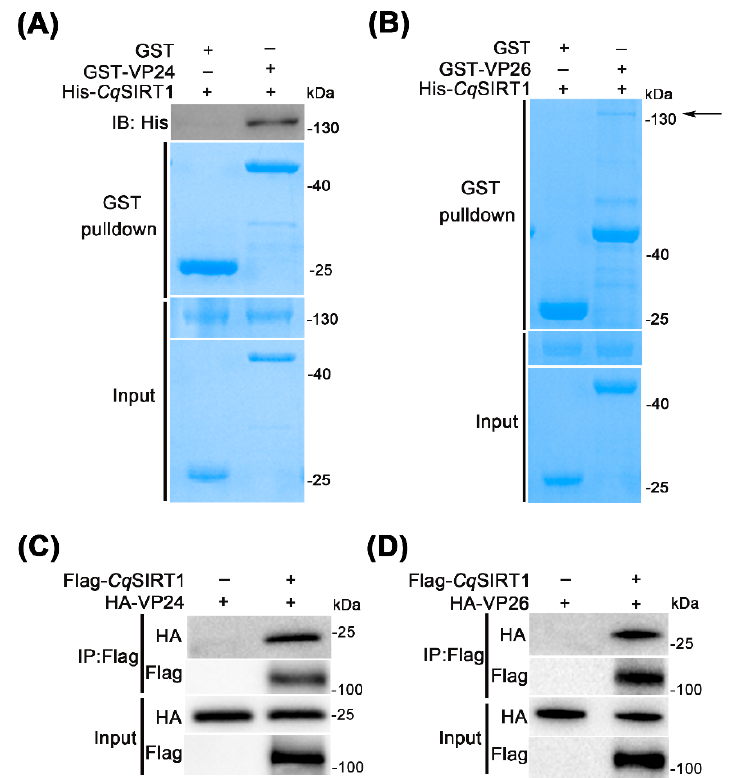
Figure 6. Cq SIRT1 bound to viral envelope proteins VP24 and VP26. ( A , B ) GST pulldown assay between recombinant protein Cq SIRT1 and VP24 or VP26. The GST pulldown assay was performed and followed by Coomassie brilliant blue staining and Western blot analysis with anti-His monoclonal antibody. GST recombinant protein served as negative control. ( C , D ) Flag- Cq SIRT1 was found to bind to HA-VP24 or HA-VP26 in the co-immunoprecipitation assay. Flag- Cq SIRT1 and HA-VP24 or HA-VP26 plasmids were co-transfected into HEK293T cell lines, then subjected to co-immunoprecipitation and Western blot analysis with the indicated specific antibody. These experiments were performed in biological triplicates.